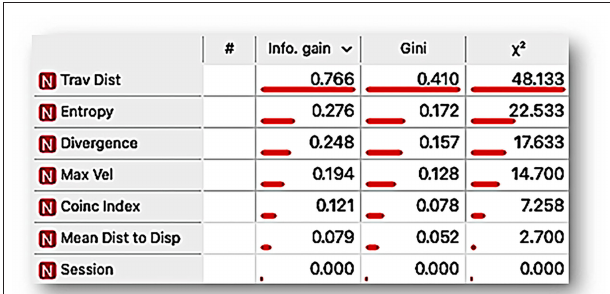
FIGURE 5 | Ranking variable analysis, under information gain , mean decrease impurity Gini index , and χ 2 procedures for the features traveled distance per session (Trav Dist), entropy, divergence, maximum velocity per session ( Max Vel ), coincidence index ( Coinc index ), mean distance to the dispenser ( Mean Dist to Disp ), and session. The length of the bar ranks the features by the scoring value that measures the relevance of each feature to differentiate the behavioral system as a function of a given time-based schedule (FT vs. VT).